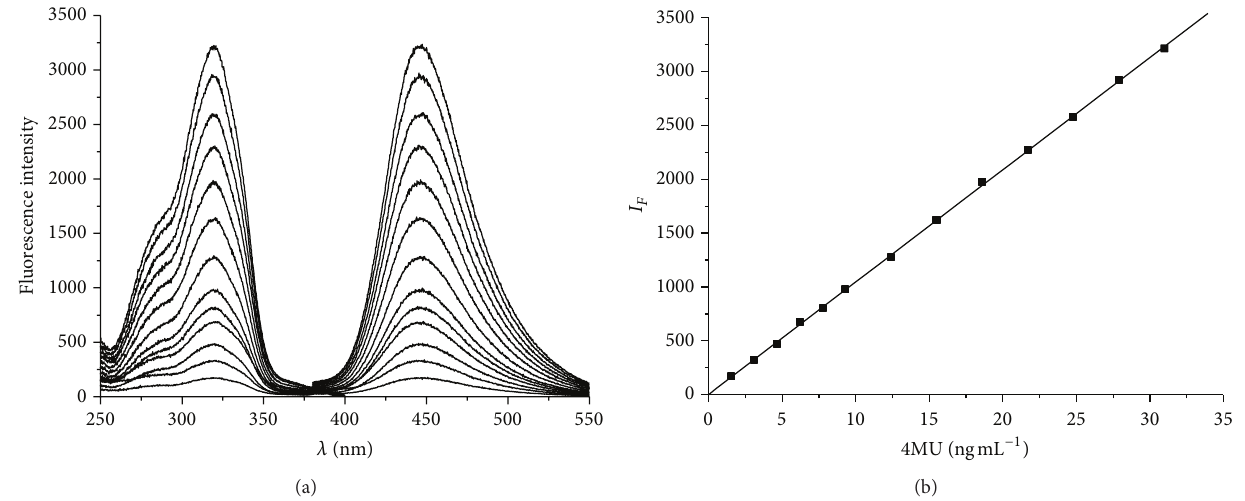
Figure 7: (a) Fluorescence spectra of 4MU in different concentrations; (b) plot of fluorescence intensity versus concentration. pH: 5.98; 𝜆 / 𝜆 : 320 nm/445 nm. ex em